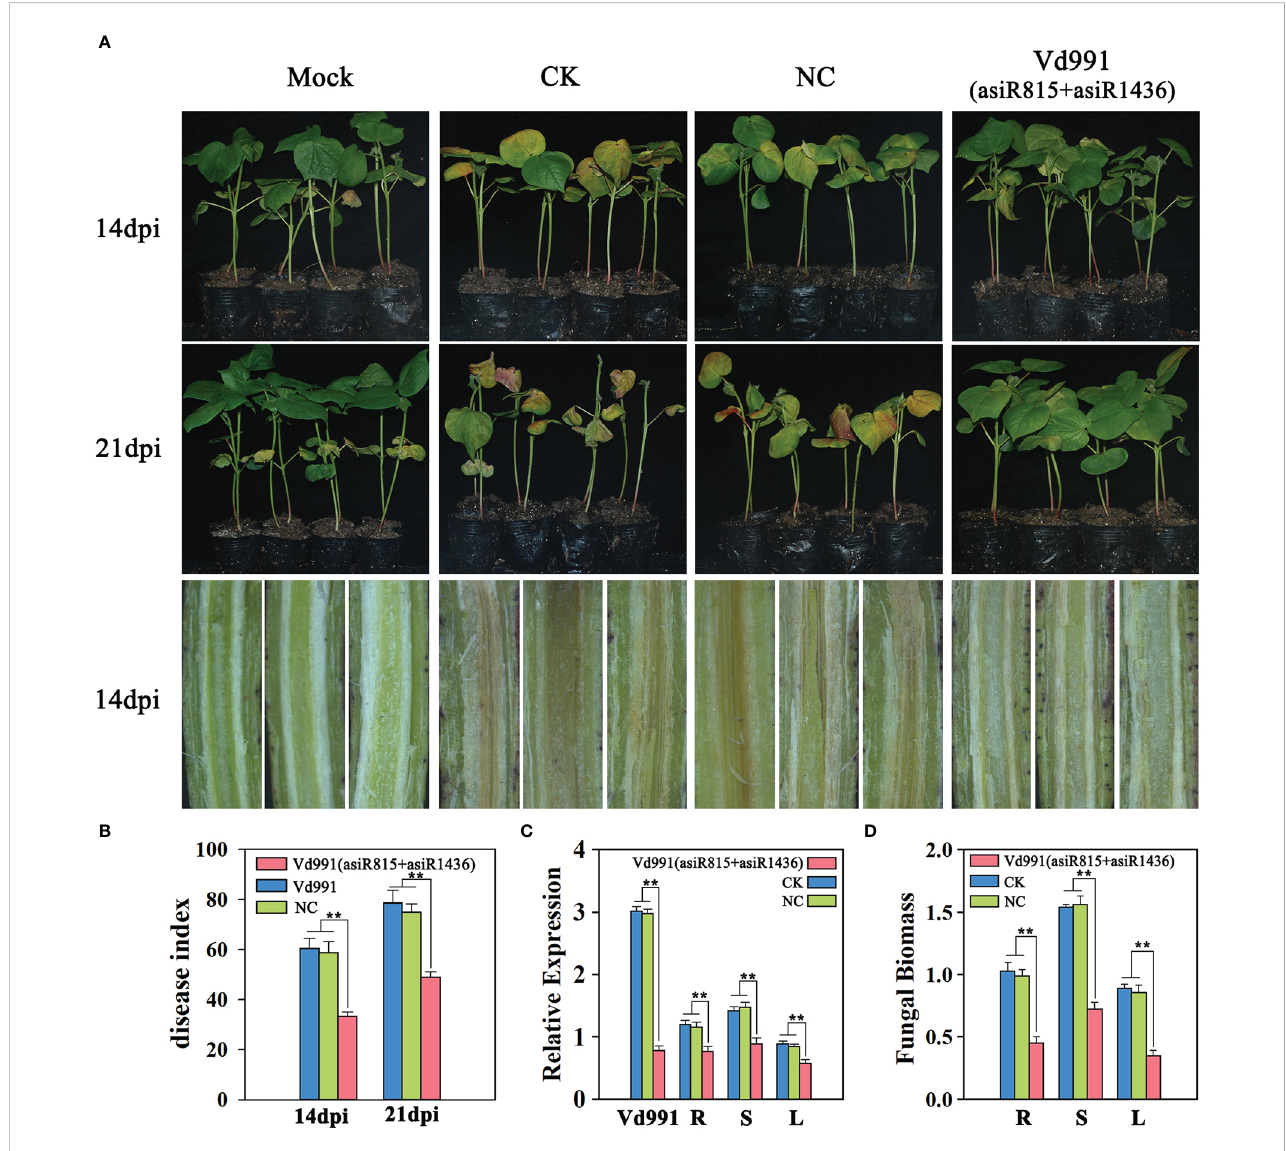
FIGURE 7 Effect of asiRNAs (asiRNA815+asiRNA1436) targeting VdST12 on the pathogenicity of V. dahliae . (A) Fungal infection symptoms of cotton seedlings infected by Vd991 (asiRNA815+asiRNA1436). Wild-type Vd991 was used as control (CK), and Vd991 co-cultured with nematode asiRNA was used as negative control (NC). (B) Disease index of seedlings infected by Vd991 (asiRNA815+asiRNA1436) at 14 dpi and 21 dpi. (C) The expression level of VdST12 in Vd991 (asiRNA815+asiRNA1436) was detected at 6 days after co-culture and seedlings infected by Vd991 (asiRNA815+asiRNA1436) was detected at 14 dpi by qRT-PCR analysis. (D) . qRT-PCR measurement of fungal biomass in seedlings infected by Vd991 (asiRNA815+asiRNA1436) at 21 dpi. The data were statistically analyzed by the IBM SPSS statistics 26.0. Statistical signi fi cance was determined using Student ’ s t-test. Asterisks (**) above the error bars indicated signi fi cant differences at p < 0.01 between seedlings infected by asiRNA-treated Vd991 and wild-type Vd991 (CK) and